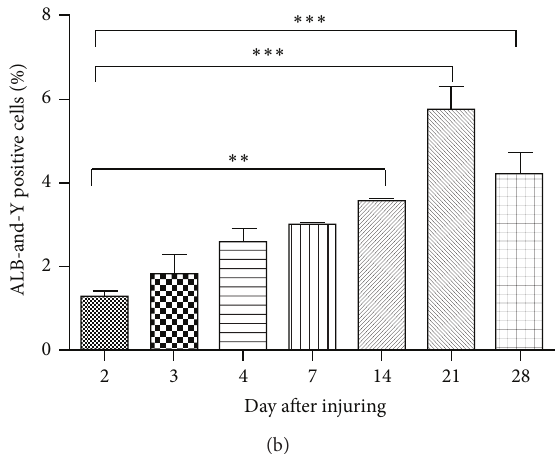
Figure 1: MSCs recruited to injured tissue and transdifferentiated into hepatocyte-like cells. (a) The liver specimens were collected on days 2, 3, 4, 7, 14, 21, and 28 after injury. FISH was used to detect Y-chromosome-positive cells, and IF was used to detect ALB-positive cells. The nuclei were stained blue (DAPI). The images were then merged. Bar: 75 𝜇 m. Arrow was directed to the double positive cells. All the experiments were repeated three times, at least 3 samples were included in each group. (b) Quantitative data of the ALB and Y-chromosome-positive cells in IHC of different days after injuring ( ∗∗ 𝑃 < 0.01 ; ∗∗∗ 𝑃 < 0.001